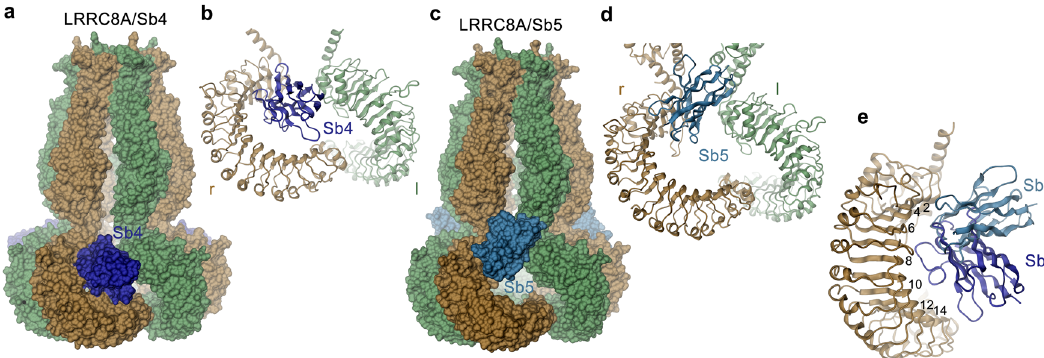
Fig. 7 Structure of LRRC8A in complex with the potentiating sybodies Sb4 and Sb5. a Surface representation of the LRRC8A/Sb4 complex structure. b Structure of the dimer of interacting domains at the loose interface with bound Sb4. c Surface representation of the LRRC8A/Sb5 complex structure. d Structure of the dimer of interacting domains at the loose interface with bound Sb5. b , d Left (l) and right (r) positions are indicated. e Ribbon representation of a single LRR domain with bound sybodies Sb4 and Sb5. Repeats contacted by one of the two sybodies are labeled. a – e Due to the low resolution of cryo-EM densities of binders in the respective maps, Sb4 and Sb5 structures are based on homology models of